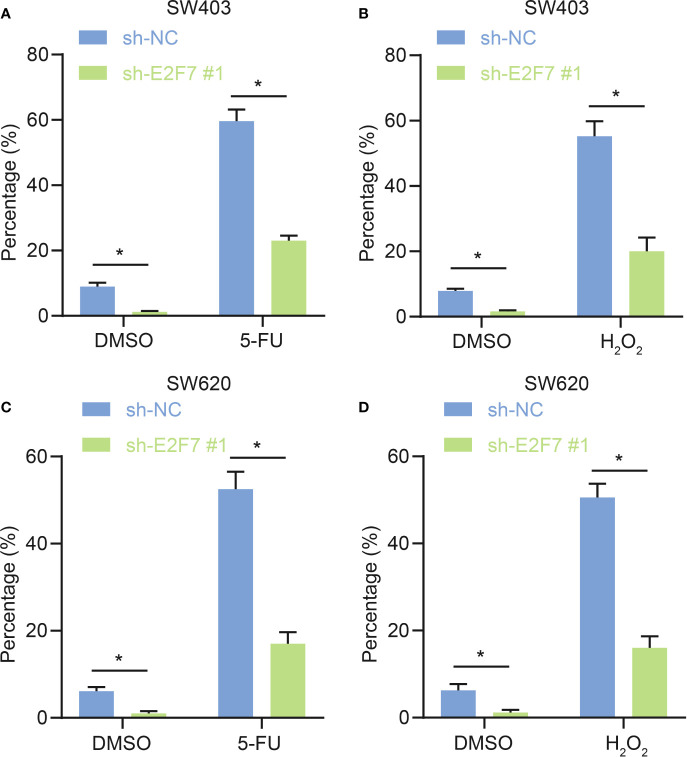
E2F7 silencing represses antagonistic effects of ALDH1+ cells on 5-FU treatment and oxidative stress. (A) In SW403, flow cytometry and quantitative analysis of the effect of E2F7 silencing on antagonism of ALDH1+ cell to effects of 5-FU treatment. (B) In SW403 cells, flow cytometry and quantitative analysis of the effect of E2F7 silencing on antagonism of ALDH1+ cells to H2O2 treatment. (C) In SW620 cells, flow cytometry and quantitative analysis of the effect of E2F7 on ALDH1+ cell antagonist 5-FU. (D) In SW620 cells, flow cytometry and quantitative analysis of the effect of E2F7 on ALDH1+ cells antagonizing H2O2 treatment. Data between two groups were compared using unpaired t-test. *p < 0.05. The experiment was repeated three times independently.